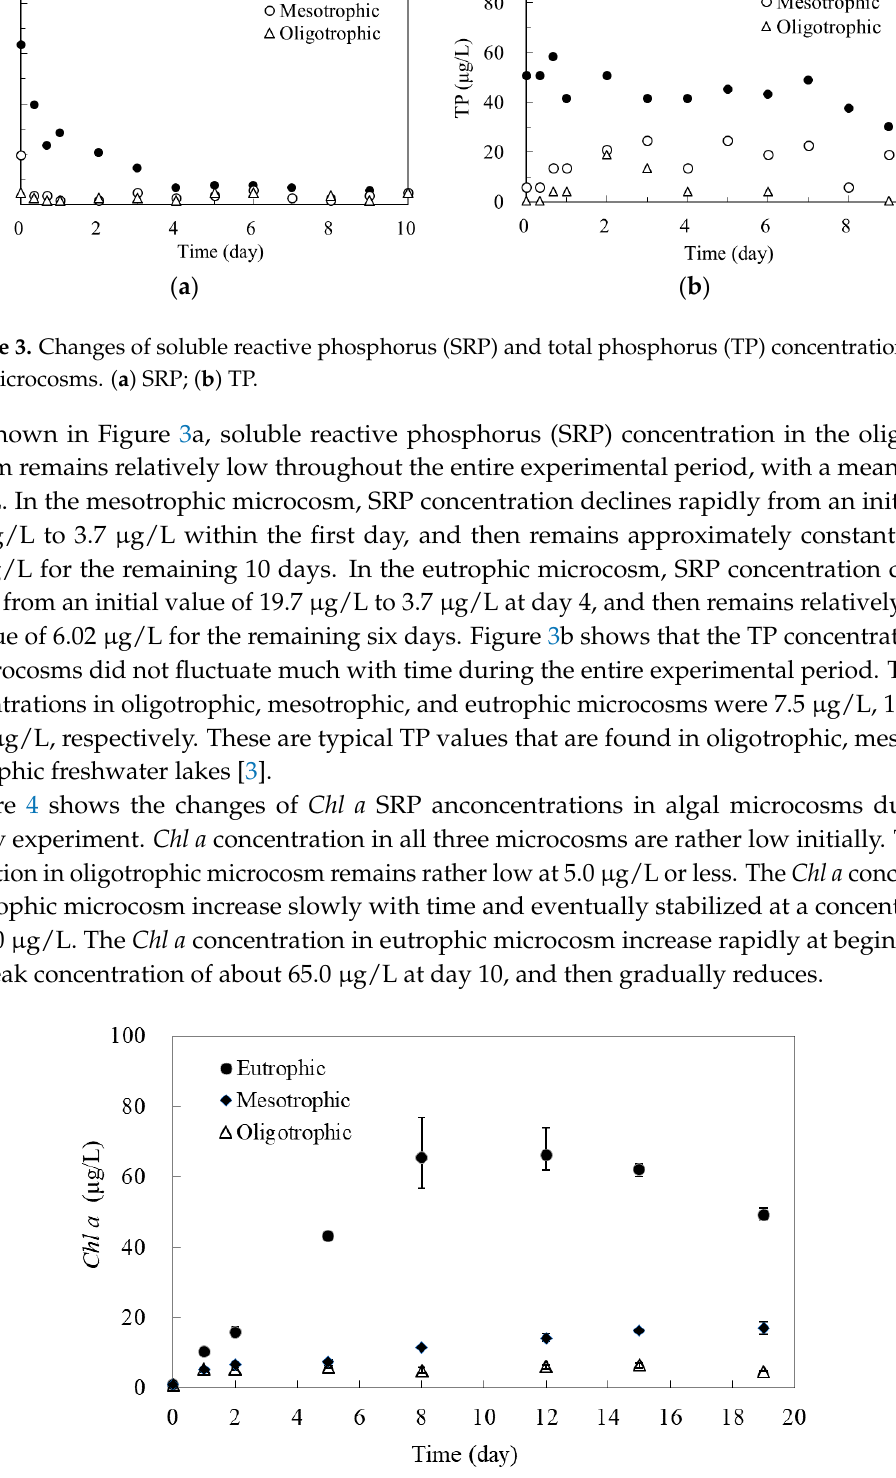
Figure 4. Chl a concentration observed in algal microcosms.